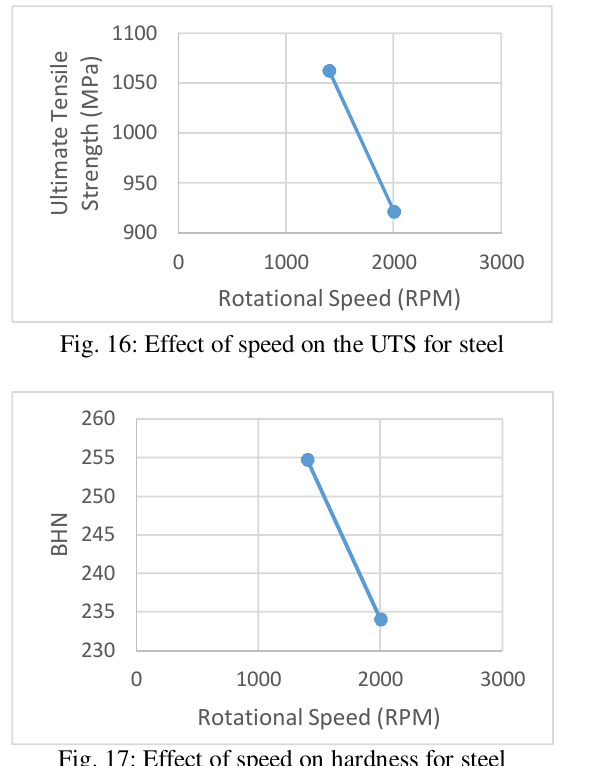
Fig. 17: Effect of speed on hardness for